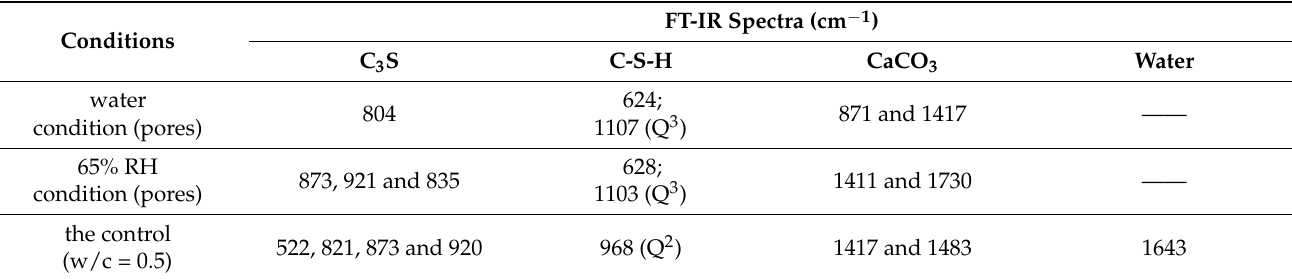
Table 3. FT-IR bands and distribution of hydration